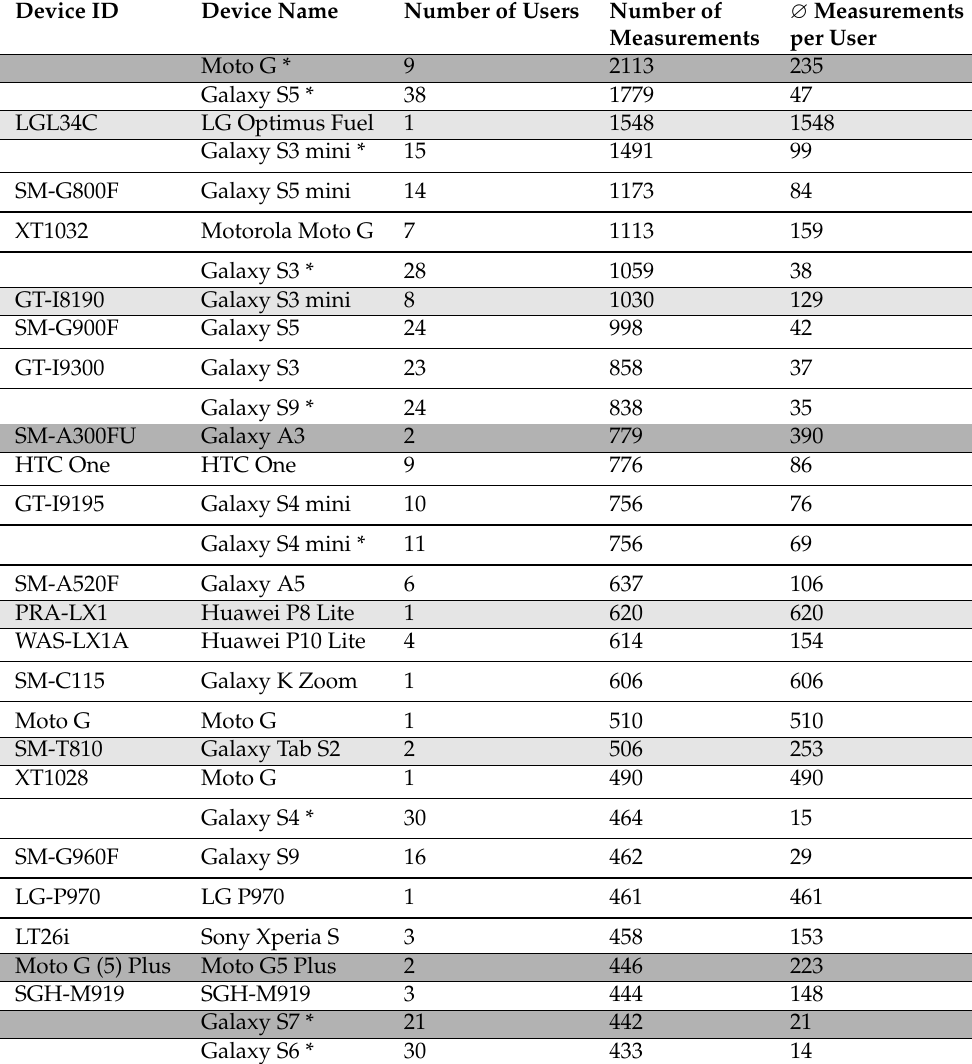
Table 2. The 30 most commonly used mobile device models, ordered descending by the number of measurements for each device model in the TYT database. The devices that were selected to perform the experiments are highlighted in gray. The devices in light gray were initially selected but could not be used because we were not able to acquire them.